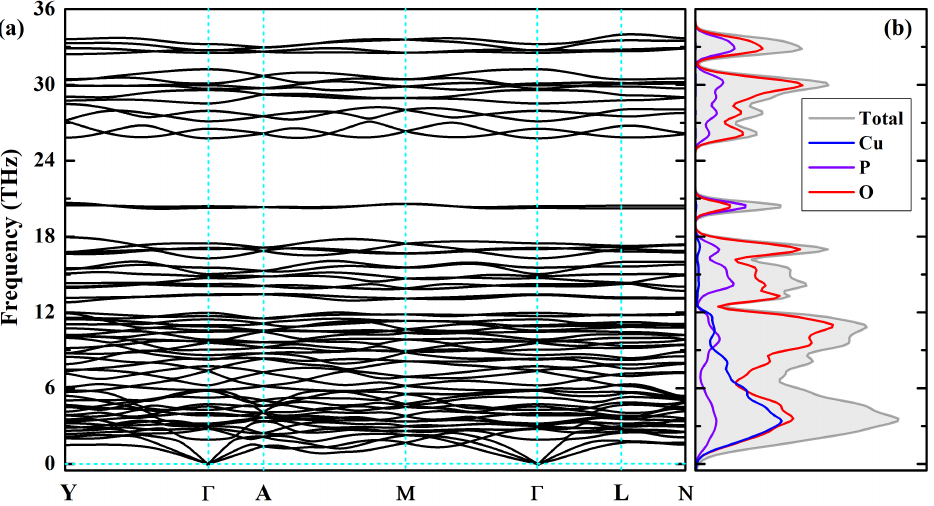
Figure 6. Phonon dispersions ( a ) and phonon density of states ( b ) of α -Cu 2 P 2 O 7 , as calculated within PBE density functional. For BZ path notations, see Figure